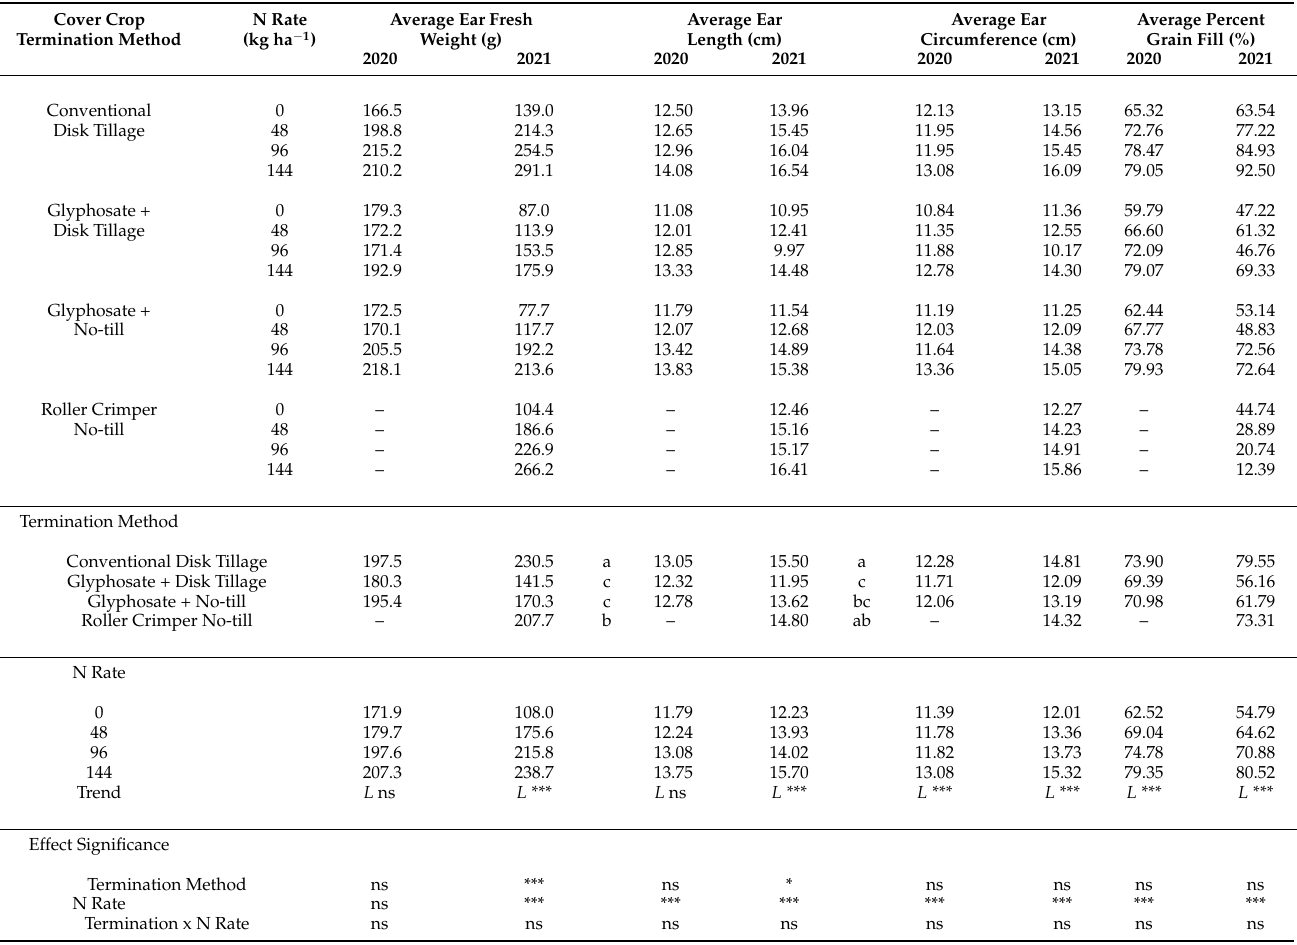
Table 3. Mean sweet corn ear quality following different cover crop terminations and N fertilizer rates in South Deerfield,